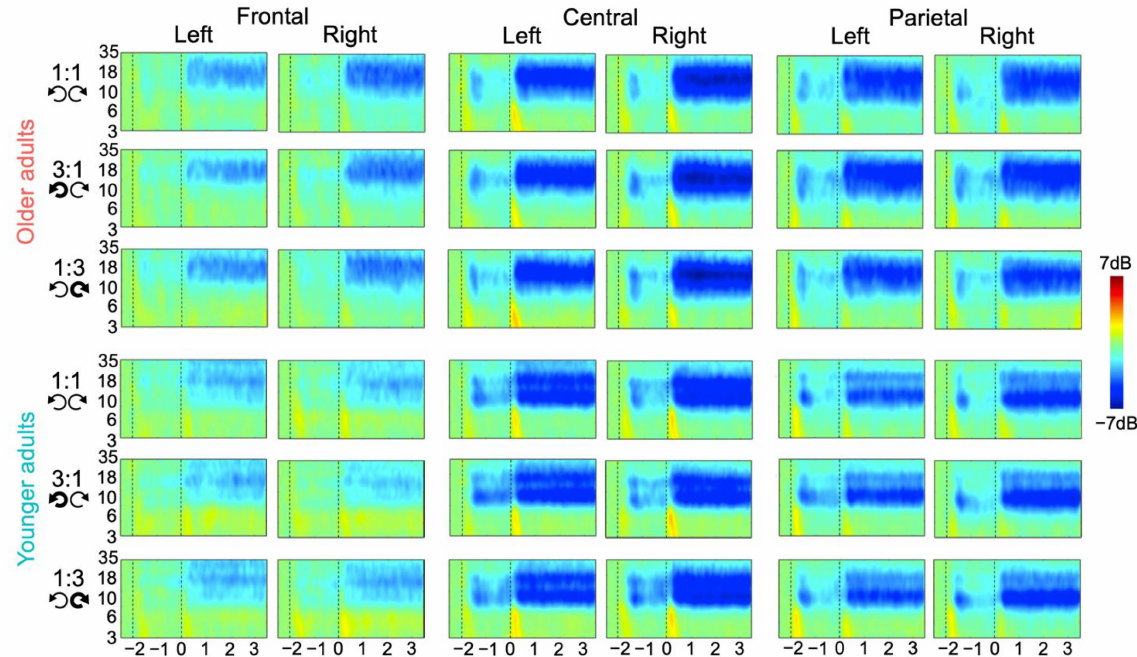
Figure 3. Time-frequency plots per group, condition, region, and hemisphere. The y-axis displays fre- quency (3–35 Hz), the x-axis displays time ( − 2.5–3.5 s), and the color scale displays power ( − 7–7 dB), with blue colors in the beta-range (13–30 Hz) reflecting movement-related beta desynchronization. Vertical dashed lines denote onset of the planning ( − 2 s) and execution stage (0 s).